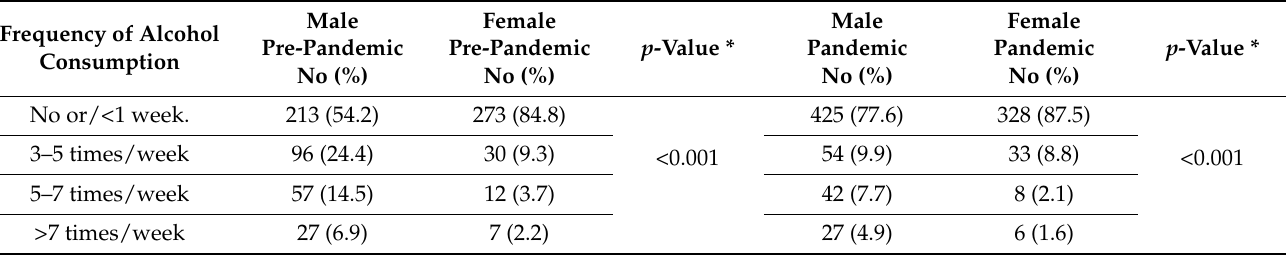
Table 6. Alcohol consumption per